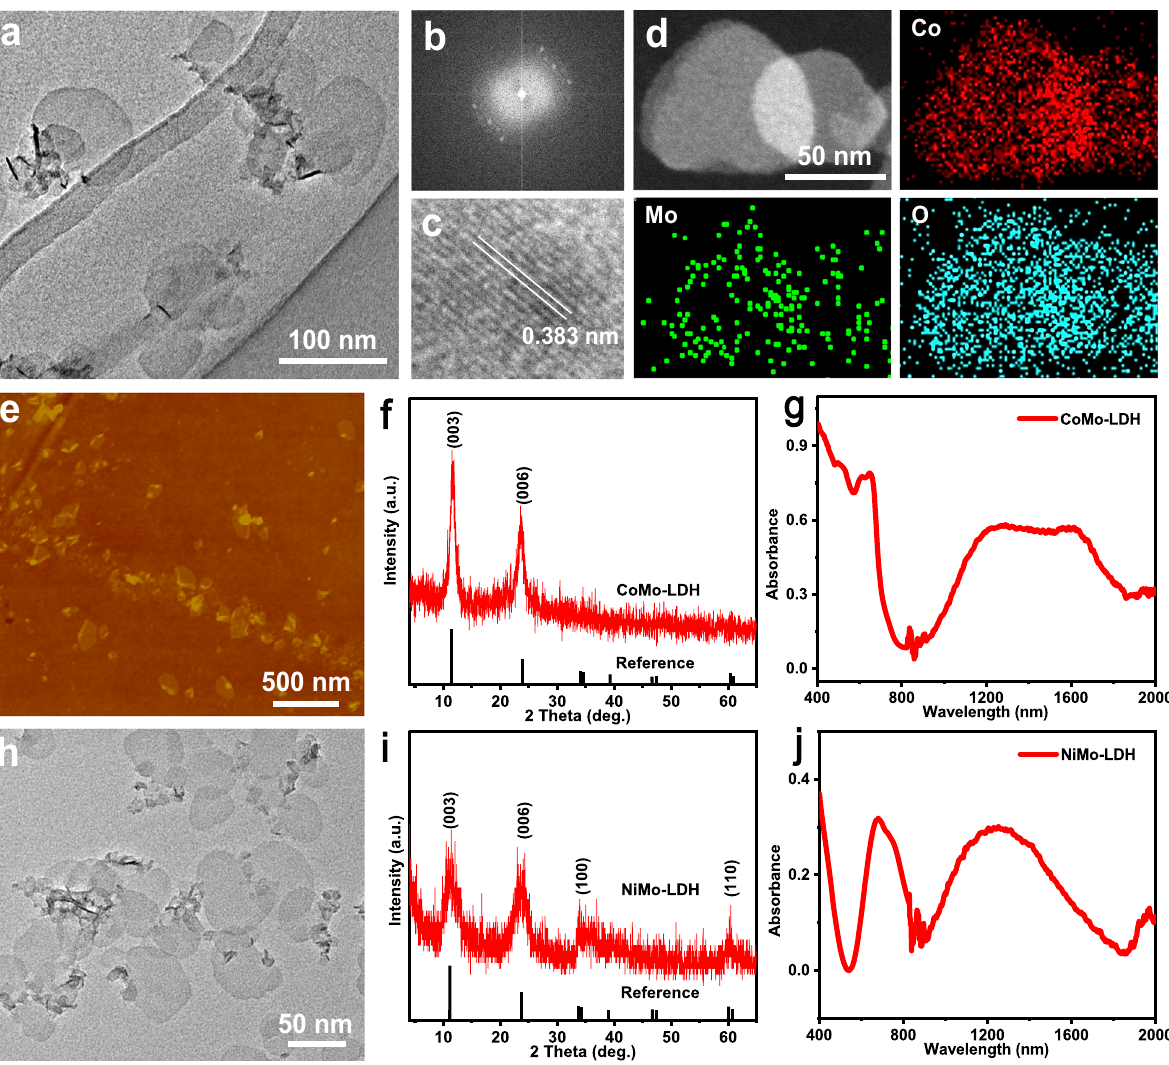
Fig. 2 Structural characterizations of CoMo-LDH and NiMo-LDH nanosheets. a TEM image, b SAED pattern and c HRTEM image, d EDX mapping and e AFM image of the CoMo-LDH nanosheets. f XRD pattern of the CoMo-LDH nanosheets. g UV – vis – NIR diffuse re fl ection spectrum of the CoMo-LDH nanosheets. h TEM image, i XRD pattern of the NiMo-LDH nanosheets. j UV – vis – NIR diffuse re fl ection spectrum of the NiMo-LDH nanosheets. Each experiment was repeated three times with similar results in all these characterization fi gures. Source data are provided as a Source Data fi